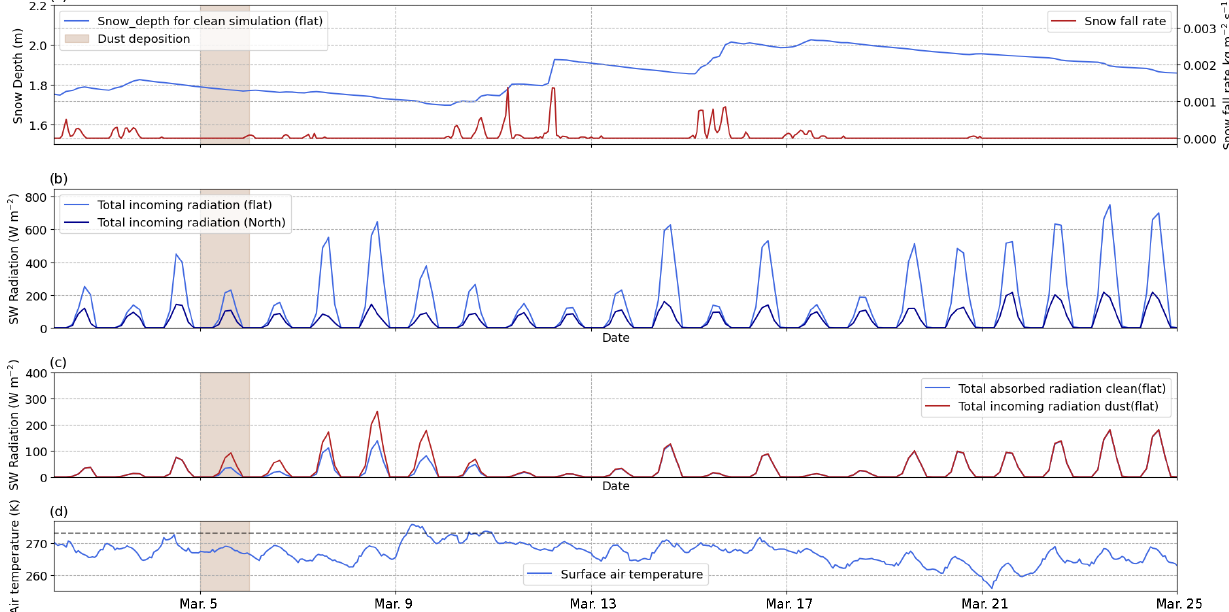
Figure 1. Meteorological and snowpack conditions in the days following the dust deposition on 5 March 2018: (a) snow depth for the no-dust simulation (flat field) and snowfall rate; (b) total amount of incoming solar radiation for a flat field and a 40 ◦ steep north-facing slope; and (d) air temperature. Panel (c) presents the energy absorbed by the snowpack for dust and no-dust simulations (member 8) on a flat surface.